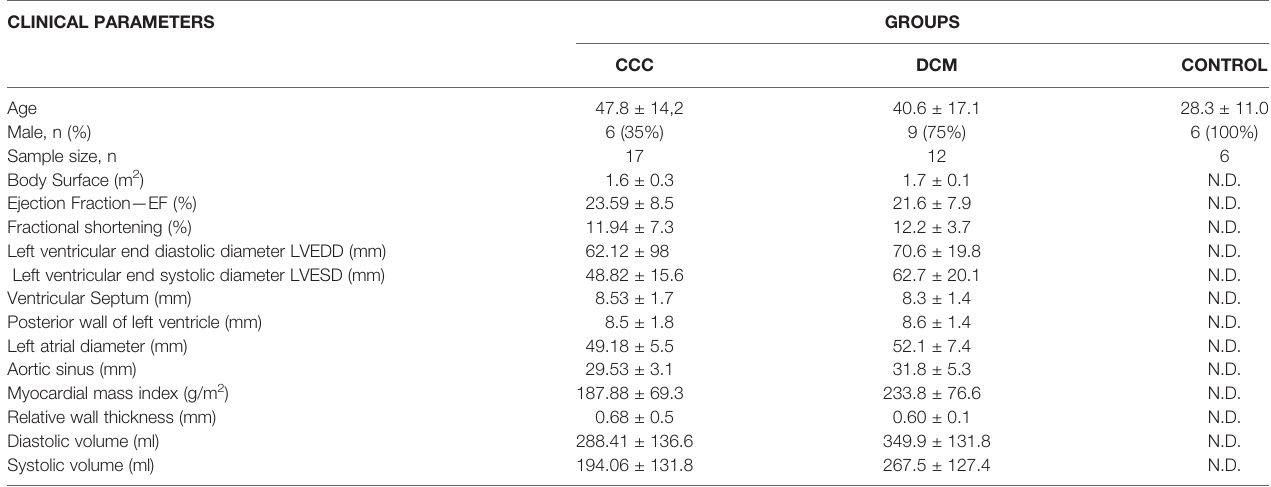
TABLE 1 | Clinical characteristics of the study subjects. CLINICAL